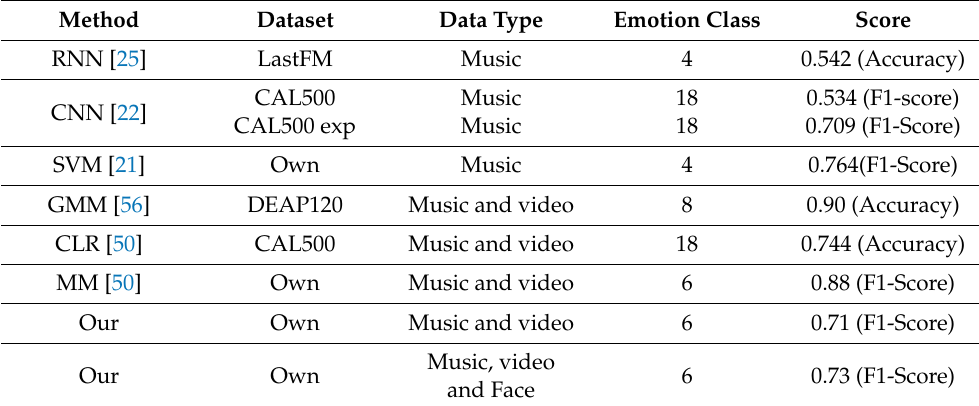
Table 8. Comparison with past